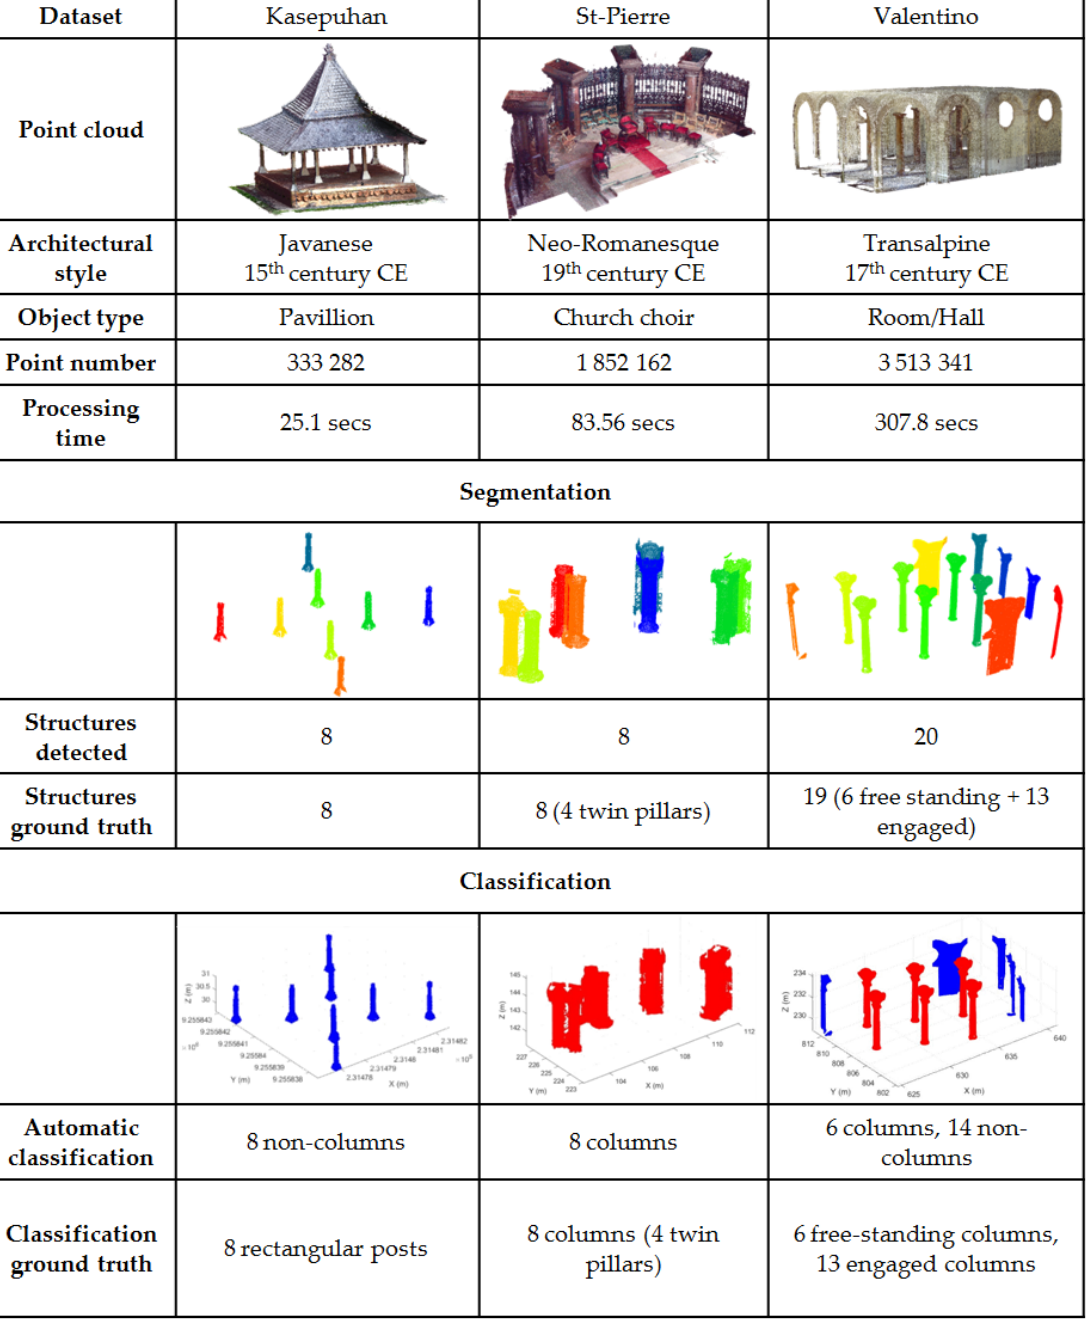
Figure 10. Results of the detection and segmentation of structural supports, as well as their subsequent automatic classification. In the segmentation part, each color denotes a different point cloud cluster, while, in the classification part, red clusters are columns and blue clusters are